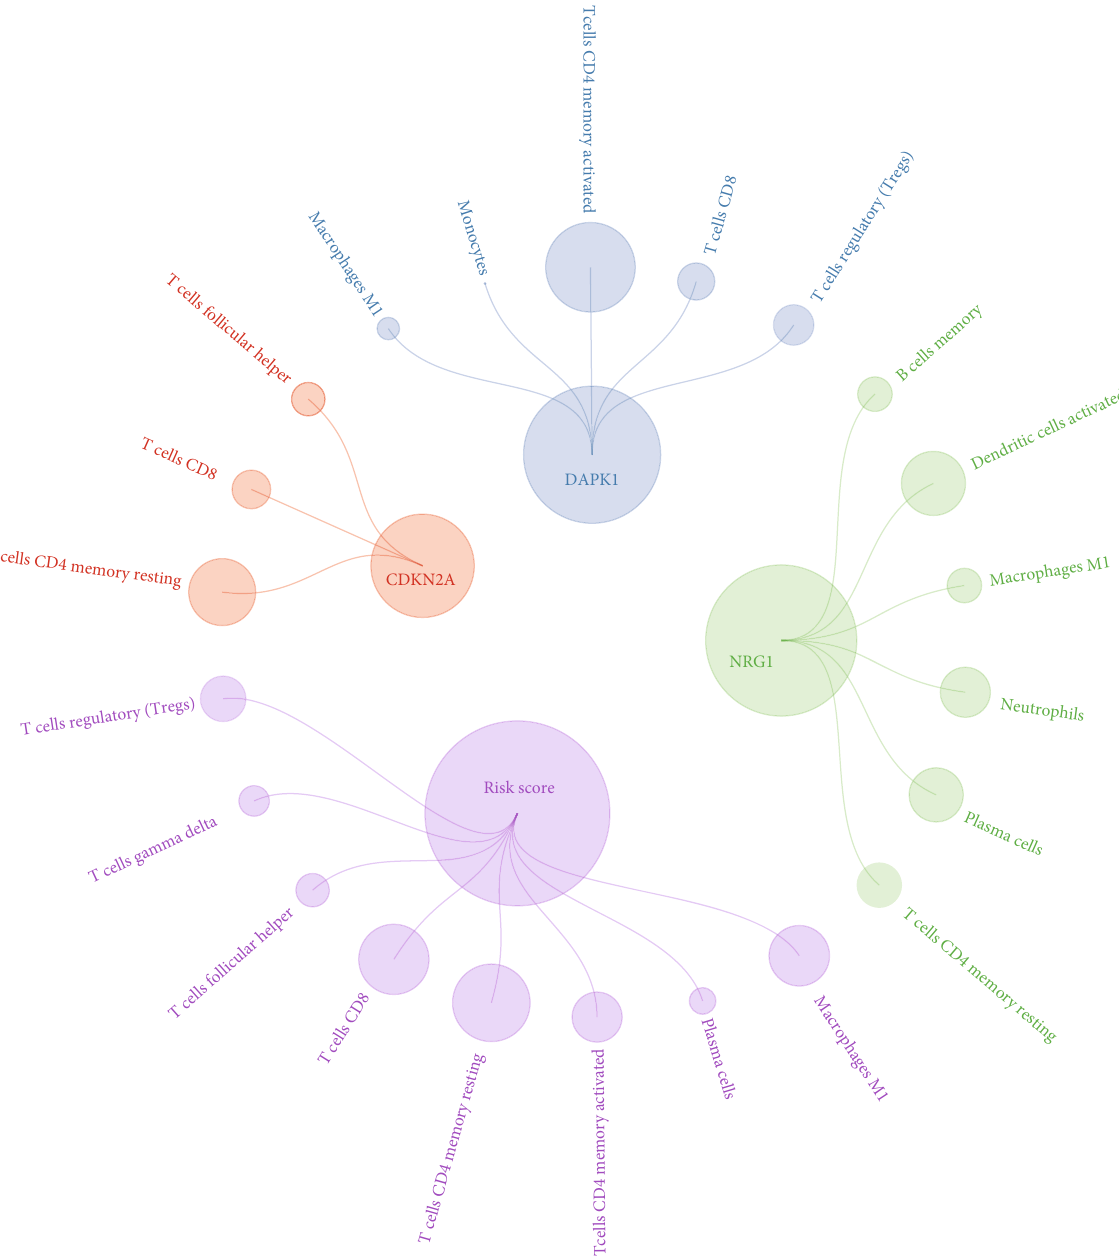
Figure 7: A circle plot exhibited the correlation of six ARP signatures and risk score with 19 types of TII cell distribution ( p Filter = 0 : 05 ). The nod size represents the |log P value| and normalized to a range of 0.5-80, where red represented the positive correlation while green represented the negative